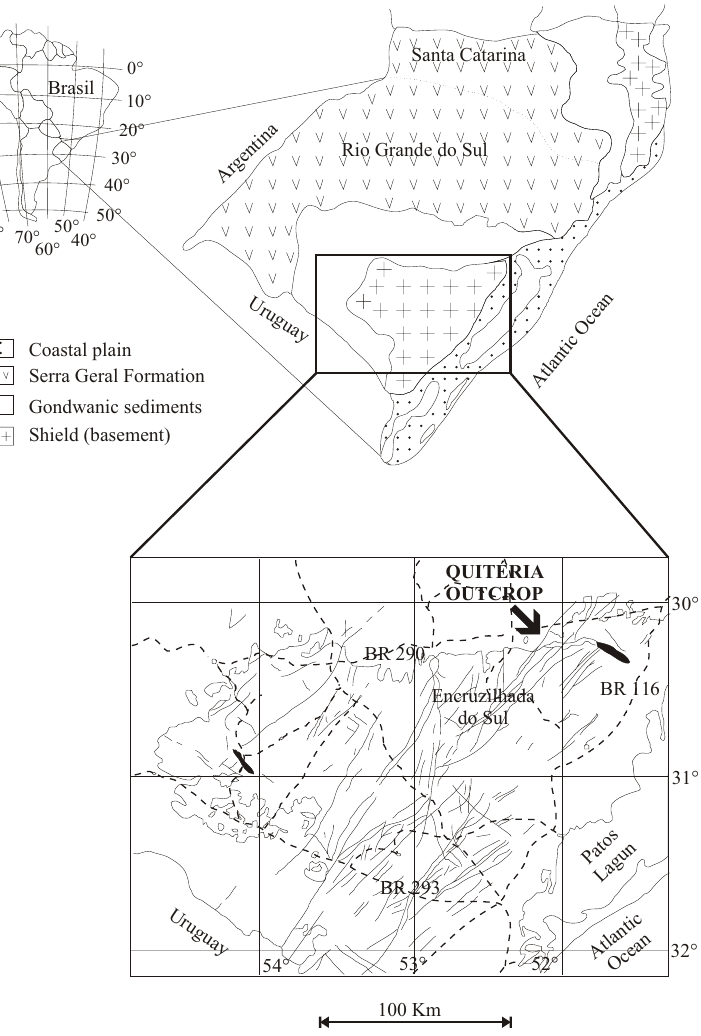
Fig. 1 – Localization of the Quitéria outcrop (adapted from Jasper et al. 2003, Fig. 2). Coricladus gen.